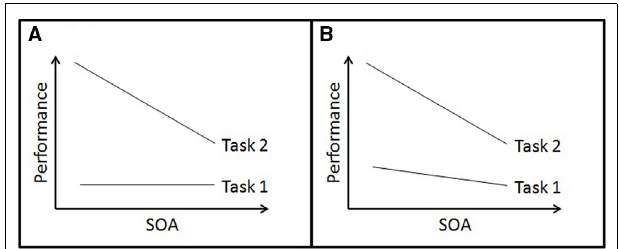
FIGURE 1 | Illustration of performance patterns in the context of dual tasks of the Psychological Refractory Period type (note, that an increase at the y axis represents performance impairment and an increase at the x axis represents an increase in stimulus onset asynchrony, SOA) . Panel (A) : Task 1 and Task 2 performance according to the central bottleneck model. Panel (B) : Task 1 and Task 2 performance according to less strict sequential interpretations of bottleneck models and impaired performance with decreasing SOA in both